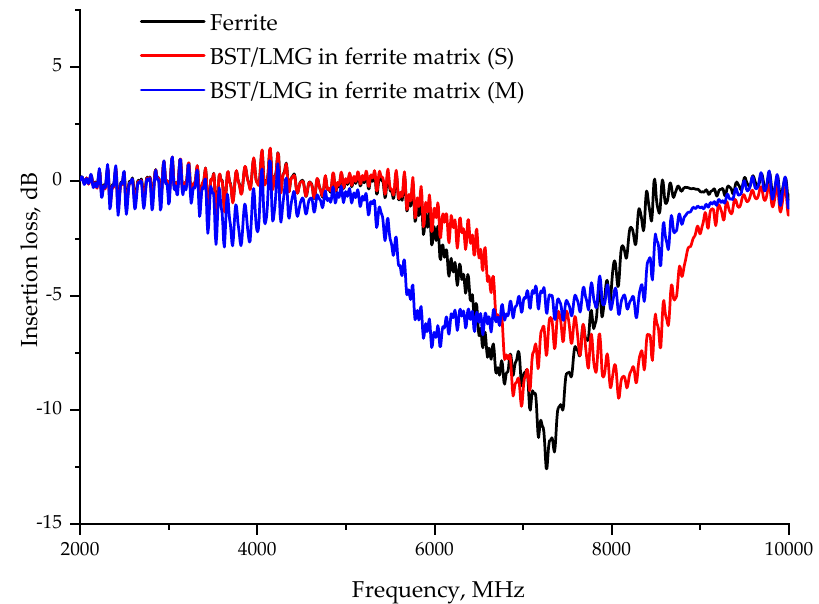
Figure 5. Transmission characteristics of samples measured at the magnitude of the magnetization field of 1685 Oe.